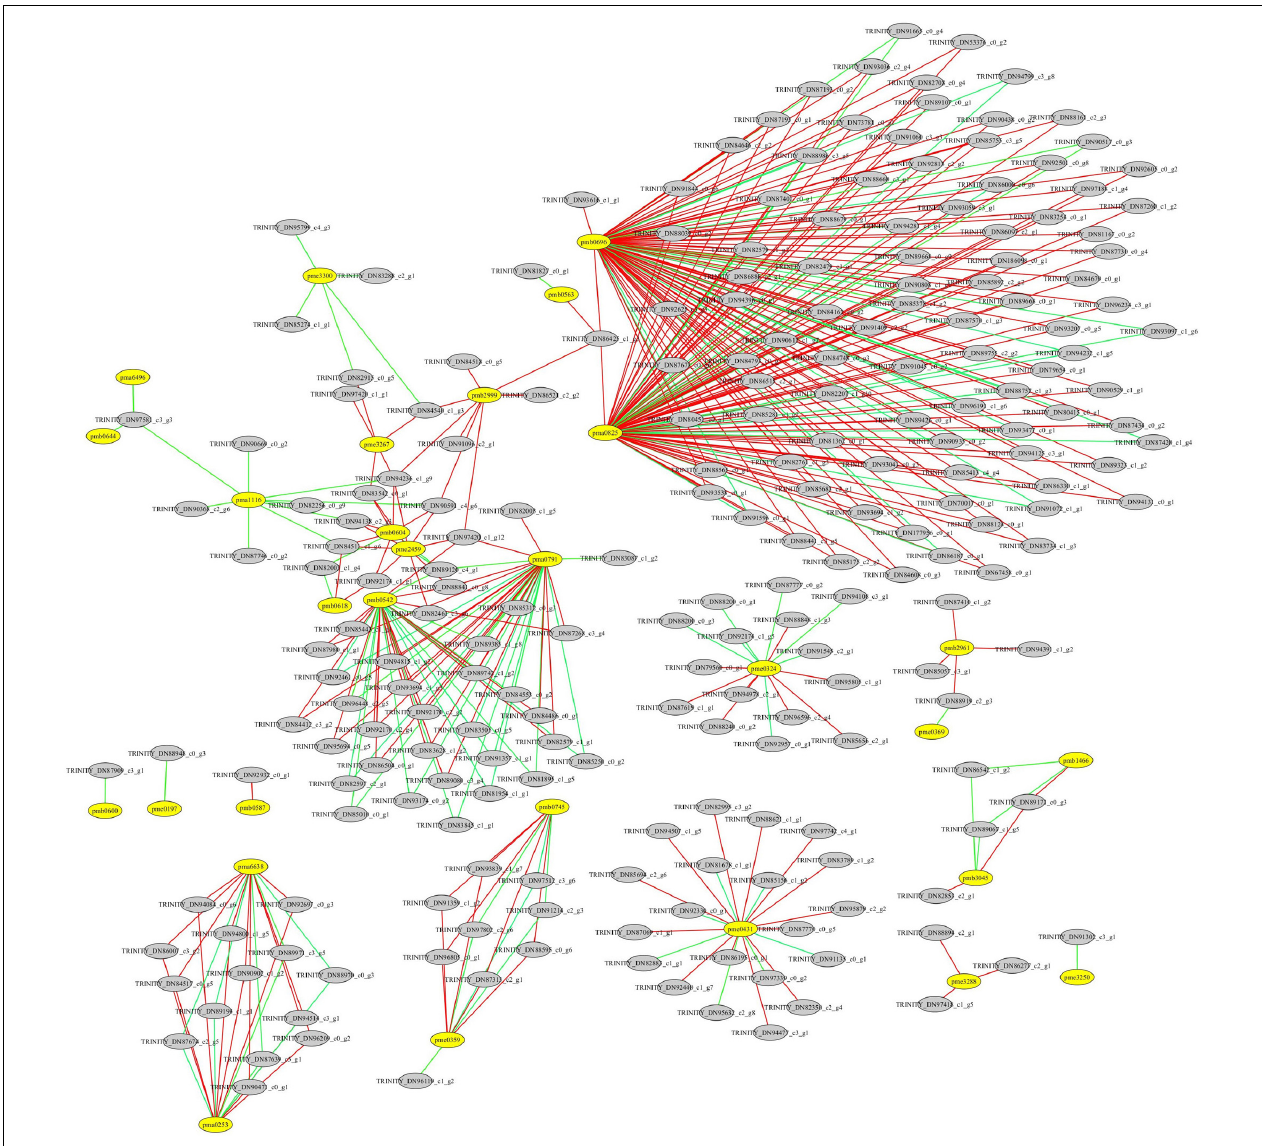
FIGURE 9 | Correlation analysis between differentially expressed genes (DEGs) and differentially accumulated flavonoids in the leaves of Cyclocarya paliurus at low and high altitudes. The yellow circle represents flavonoids; the gray circle represents DEGs. The red line indicates a significant positive correlation; the green line indicates a significant negative correlation. pma0253, O-methylchrysoeriol 5-O-hexoside; pma0791, Naringenin O-malonylhexoside; pma0825, chrysin O-malonylhexoside; pma1116, kaempferide; pma6496, luteolin 6-C-glucoside; pma6638, O-methylchrysoeriol 7-O-hexoside; pmb0542, cyaniding 3-O-malonylherxoside; pmb0563, peonidin; pmb0587, chrysoeriol O-glucuronic acid-O-hexoside; pmb0600, chrysoerio 7-O-rutinoside; pmb0604, kaempferol 3-o-glucoside; pmb0618, 8-C-hexosyl-hesperetin O-hexoside; pmb0644, luteolin C-hexoside; pmb0696, 8-C-hexosyl chrysoeriol O-hexoside; pmb0745, tricin 4 (cid:48) -O-syringyl alcohol; pmb1466, tricin 4 (cid:48) -O-syringic acid; pmb2961, peonidin O-malonylhexoside; pmb2999, chrysoeriol 5-O-hexoside; pmb3045, tricin O-glucuronic acid; pme0197, quercetin 3-O-rutinoside; pme0324, chrysin; pme0359, apigenin 5-O-glucoside; pme0369, kaempferol 3-O-rutinoside; pme0431, procyanidin A1; pme1535, gallocatechin; pme1562, epicatechin gallate; pme2459, luteolin 7-O-glucoside; pme3250, biochanin A; pme3267, kaempferol 3-O-galactoside; pme3288, 3,7-di-O-methylquercetin; pme3300,